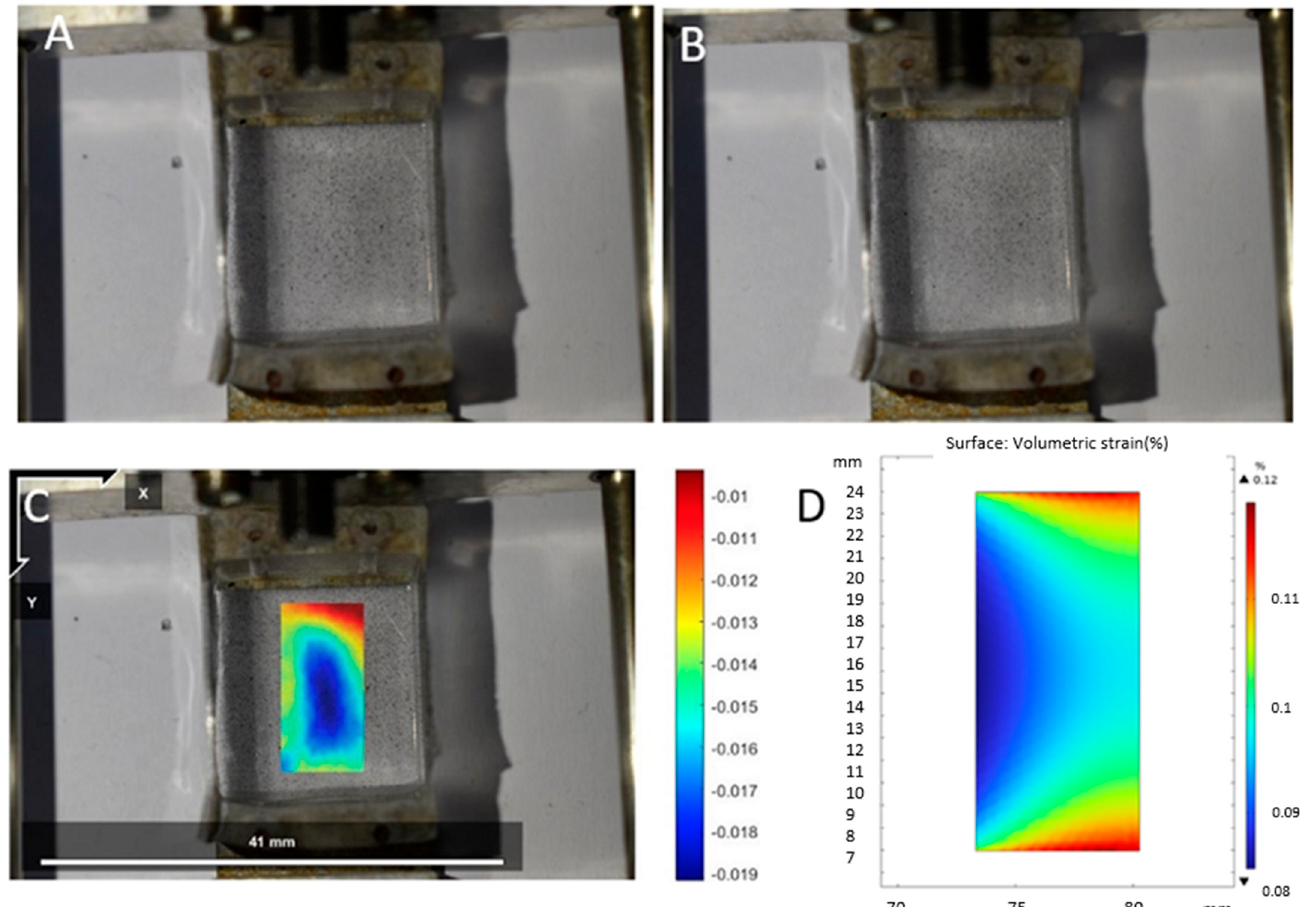
Figure 4. Evaluation of geometric deformation by digital image correlation (DIC). ( A ) Unstrained (native state) and ( B ) 5% strained state of PDMS chamber including DIC markers (paint dots). ( C ) Strain evaluated in the DIC experiment. ( D ) Strain simulated in COMSOL. For the DIC experiment, the images were obtained with a Nikon D5600; thanks to the intervalometer mode, one photograph is captured per second during several stretch cycles. The strain is set to 5%, velocity is set to 100, and the number of cycles is 5.